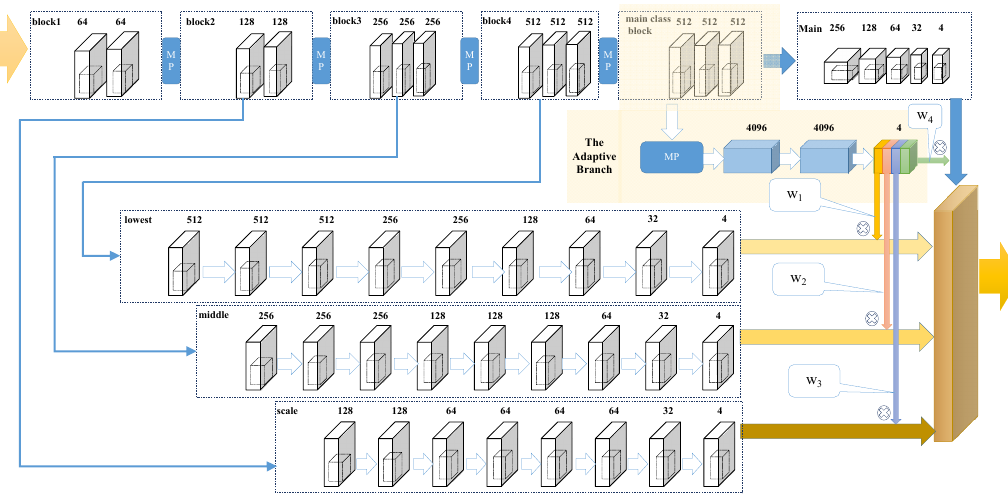
Figure 1. The architecture and weight of CAL.